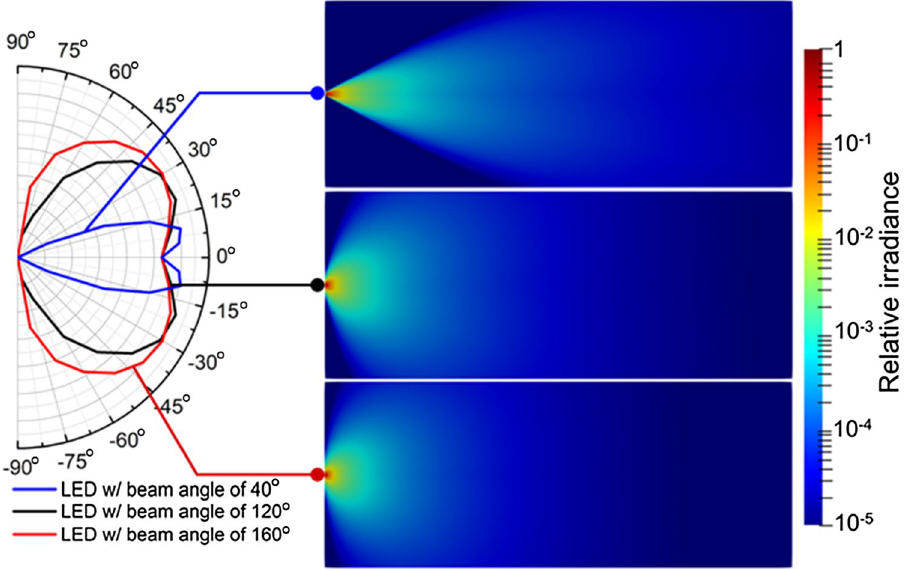
Figure 2. Radiation angular profile and irradiance of UV LED with the beam angle of 40°, 120°, and 160°,